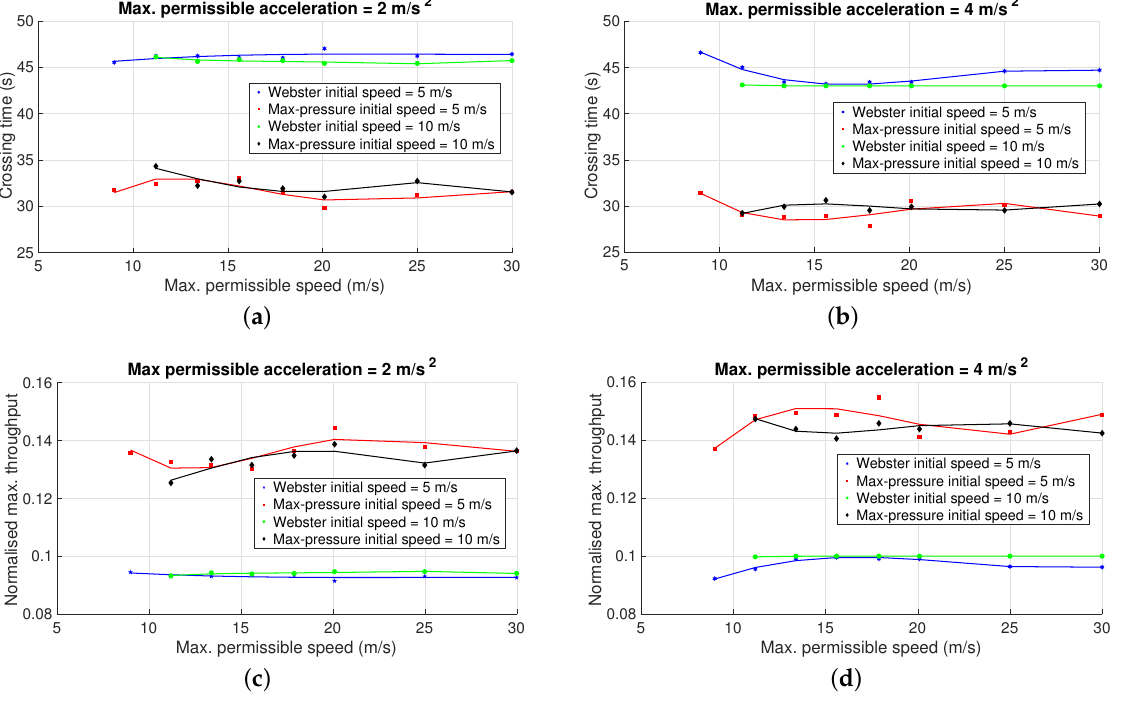
Figure 6. Variations of the crossing time when ( a ) Max. permissible acceleration is 2 m/s 2 and ( b ) Max. permissible acceleration is 4 m/s 2 and variations of maximum throughput when ( c ) Max. permissible acceleration is 2 m/s 2 and ( d ) Max. permissible acceleration is 4 m/s 2 of the signalised intersection for different values of the initial speed and the maximum permissible speed of the crossing HVs. The solid lines show trends of the variation as polynomials of order